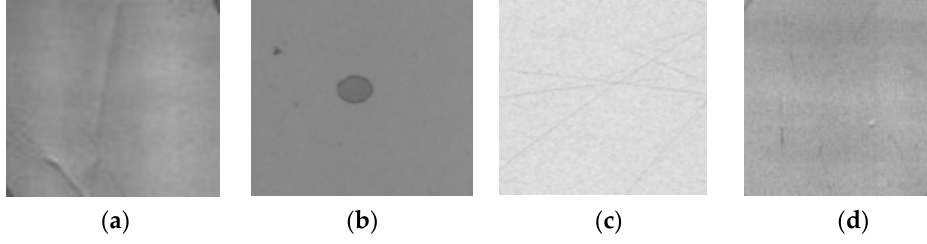
Figure 1. Different type of film surface defects; ( a ) wrinkle, ( b ) bubble, ( c ) scratch, ( d ) pit.